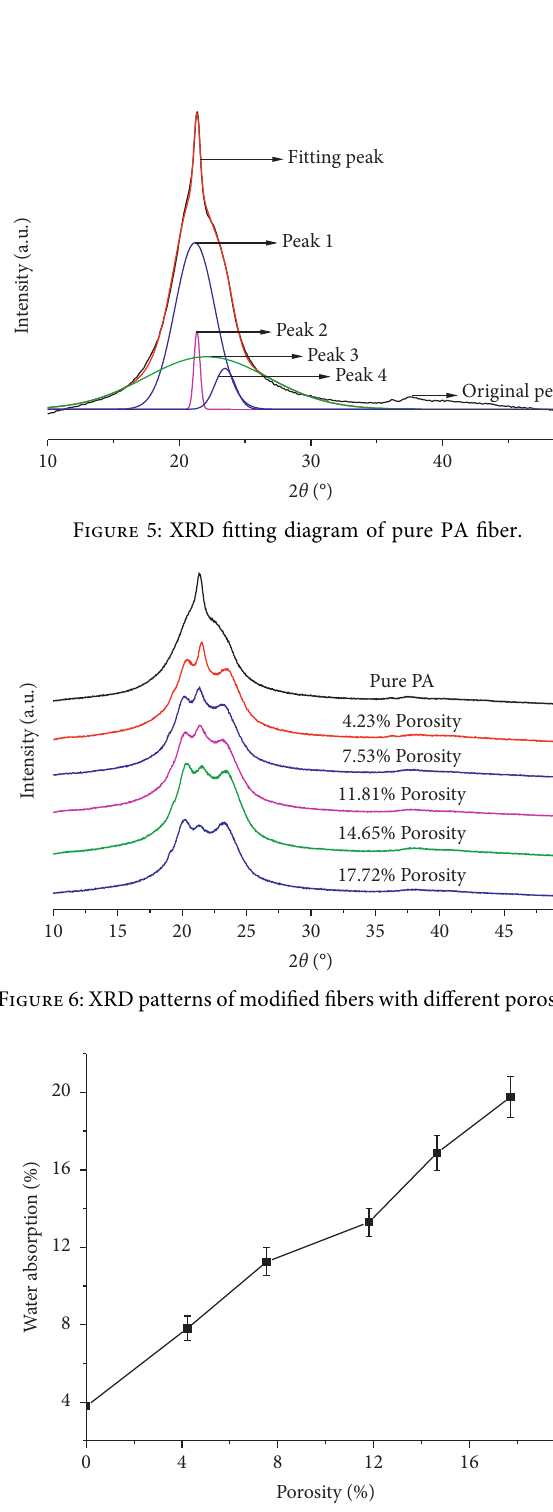
Figure 7: Water absorption of modified fibers with different